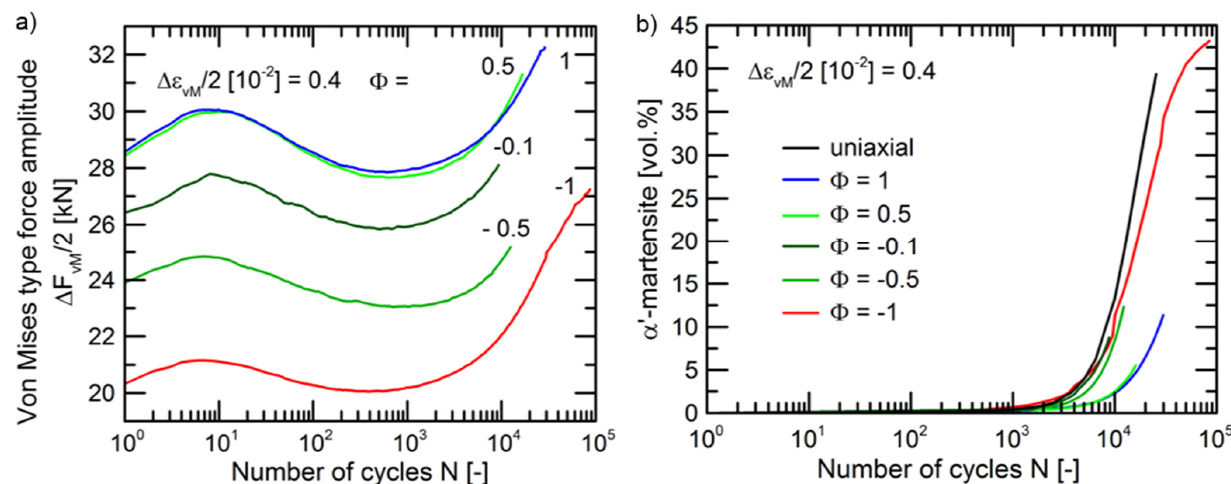
Figure 2: a) Cyclic deformation curves and b)  ’-martensite evolutions of TRIP steel PM 16-7-6 at von Mises equivalent strain amplitude Δ  vM /2 = 0.4 · 10 -2 for different strain ratios  .